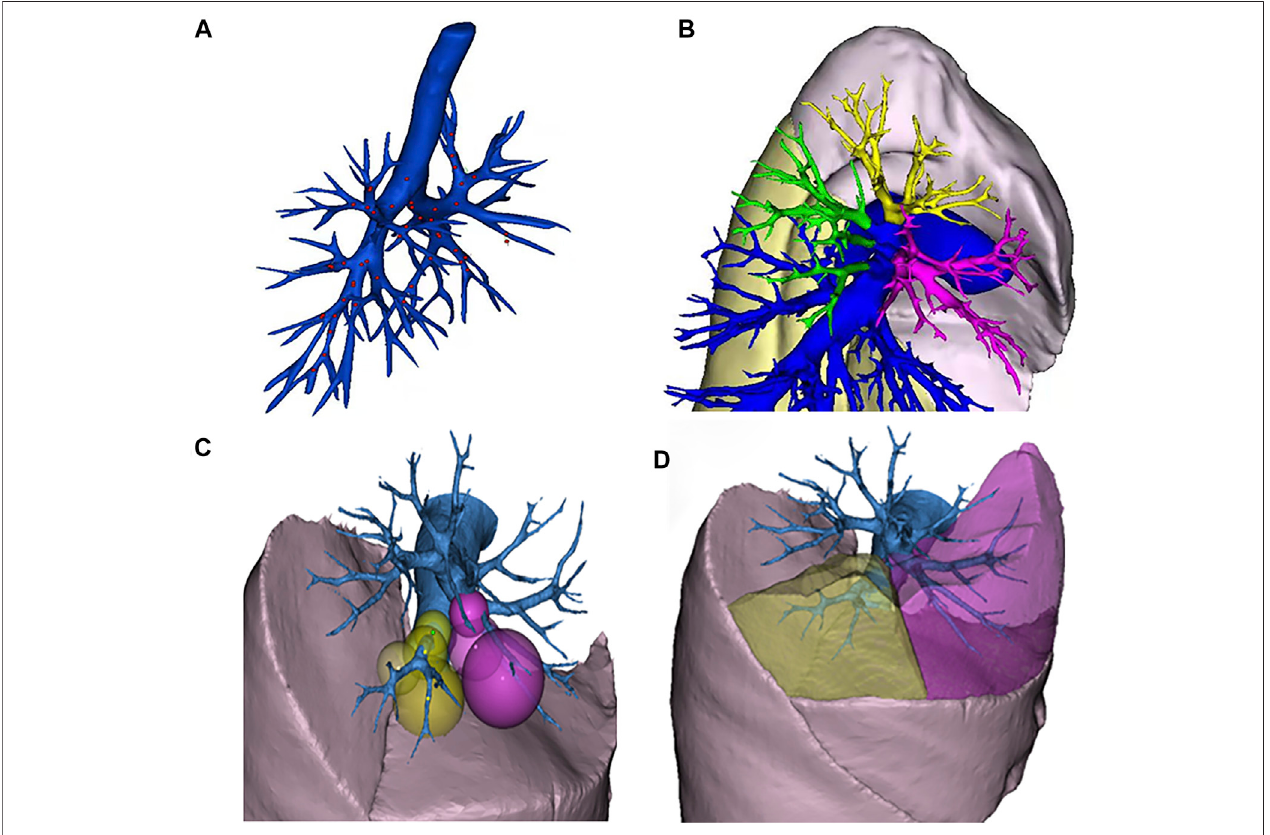
FIGURE 3 | Schematic diagram of segmental lung segmentation. Schematic diagram of segmental lung segmentation. (A) shows the initial seed points of the centerline. (B) shows the labeling of the pulmonary artery roots root. (C) shows the spherical expansion growth. (D) shows the formation of lung segments.